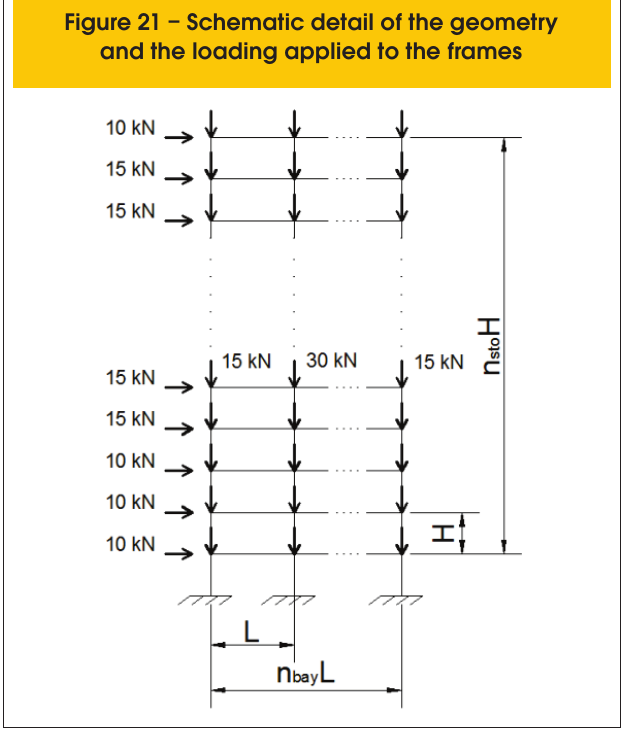
Figure 21 – Schematic detail of the geometry and the loading applied to the